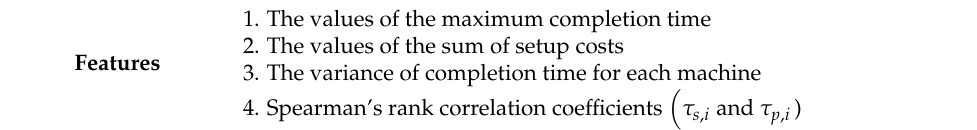
Table 3. List of features selected by SFS for small-scale problems for 2 objectives.